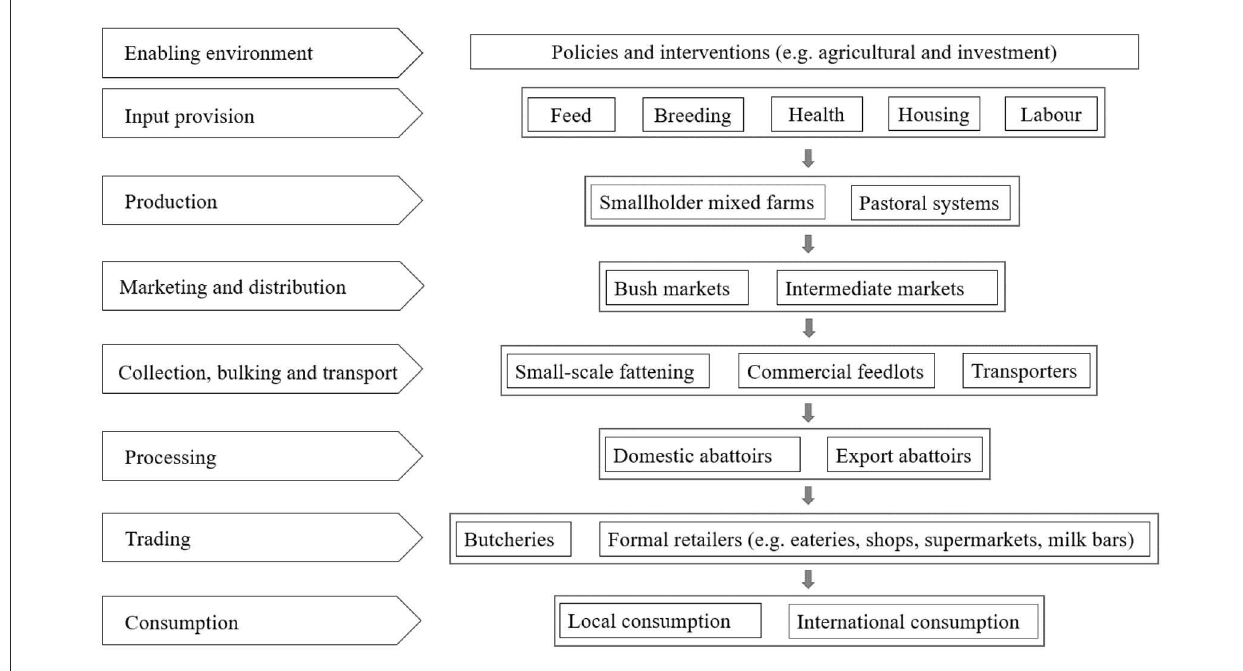
FIGURE4 Meat value chain in Addis Ababa and Oromia